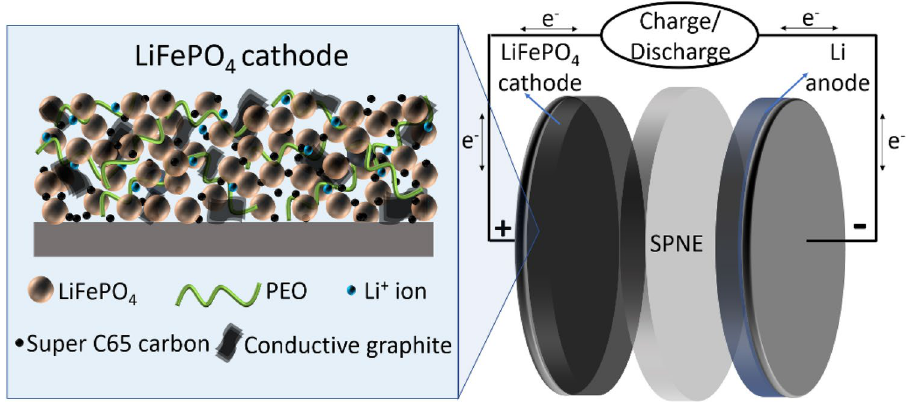
Figure 1. Schematic illustration of uniformly distributed cathode components (left) and all solid-state lithium metal battery SS-LMB